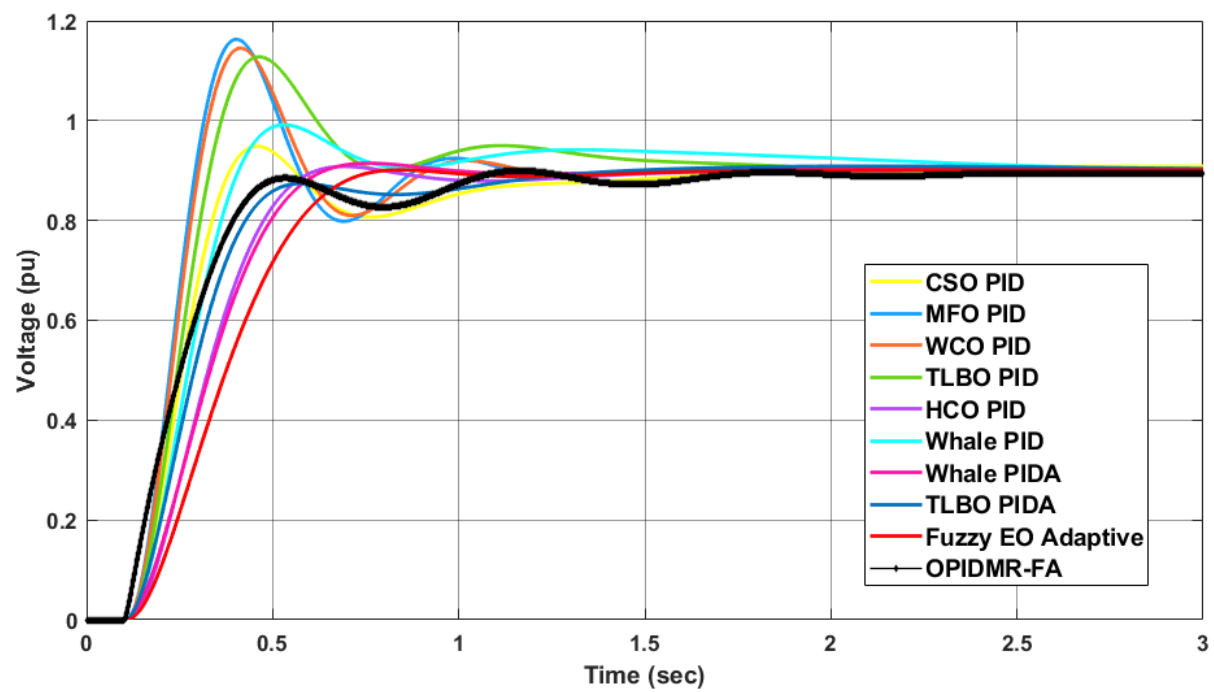
Figure 11. Step-change of 0.9 p.u. on the voltage reference of the AVR model.